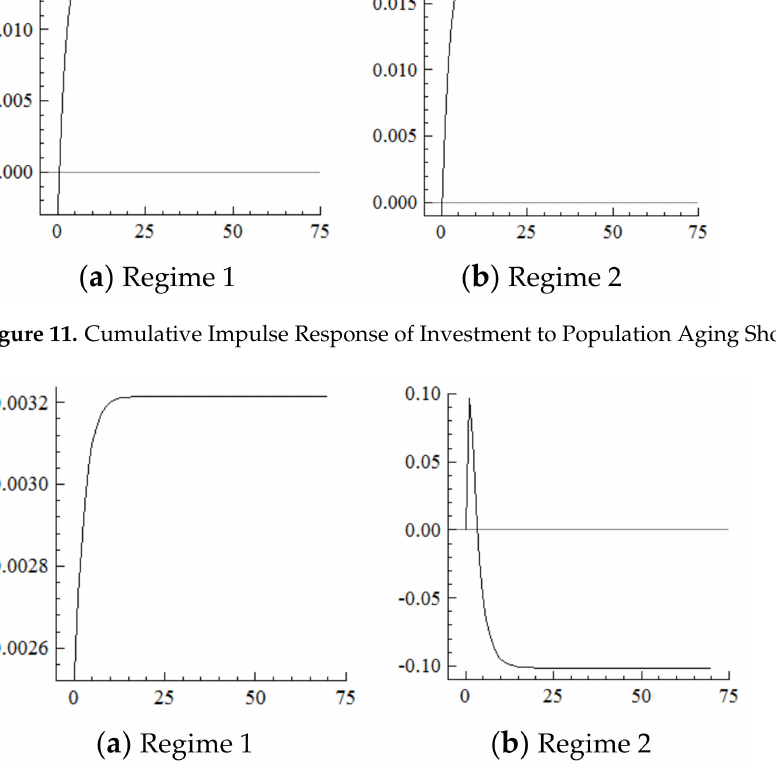
Figure 12. Cumulative Impulse Response of Industrial structure upgrading to Investment